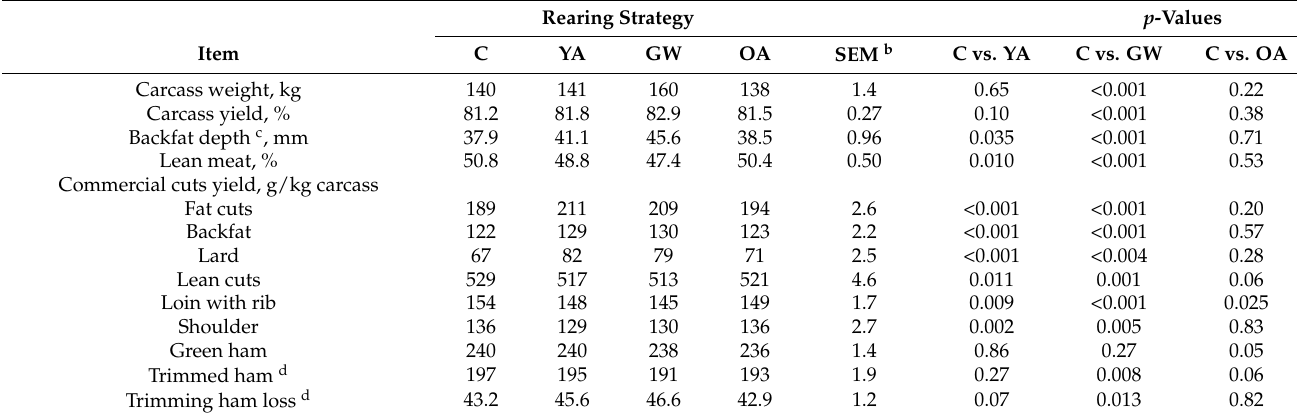
Table 5. Carcass traits of heavy pigs raised according to the traditional rearing system (control, C), and three alternative strategies (younger age, YA; greater weight, GW; and older age, OA) a .